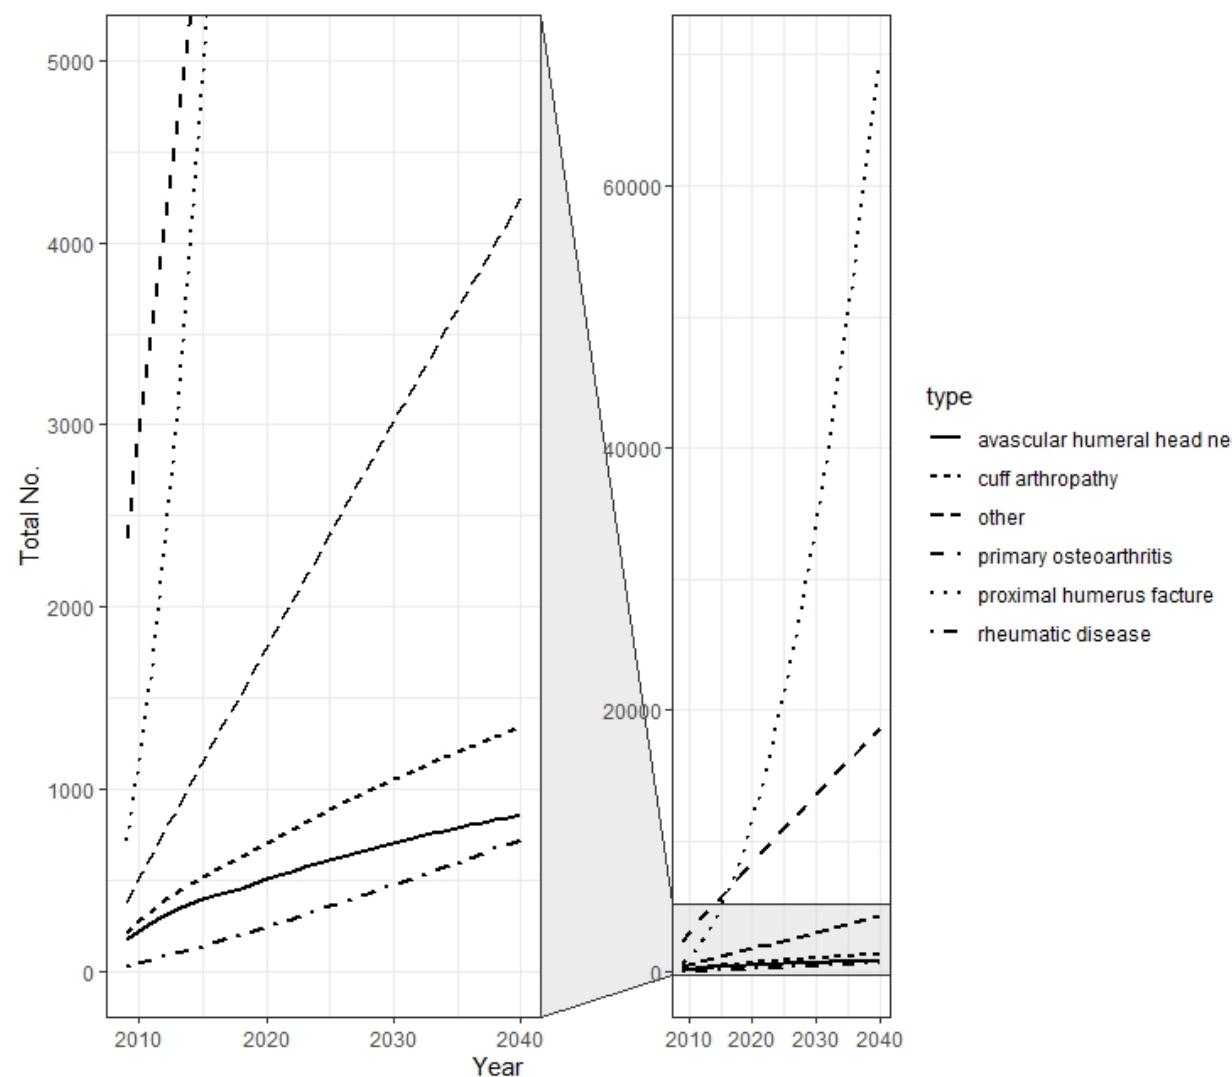
Figure 2. Historical and projected main indications for reverse shoulder arthroplasty from 2010 to 2040.